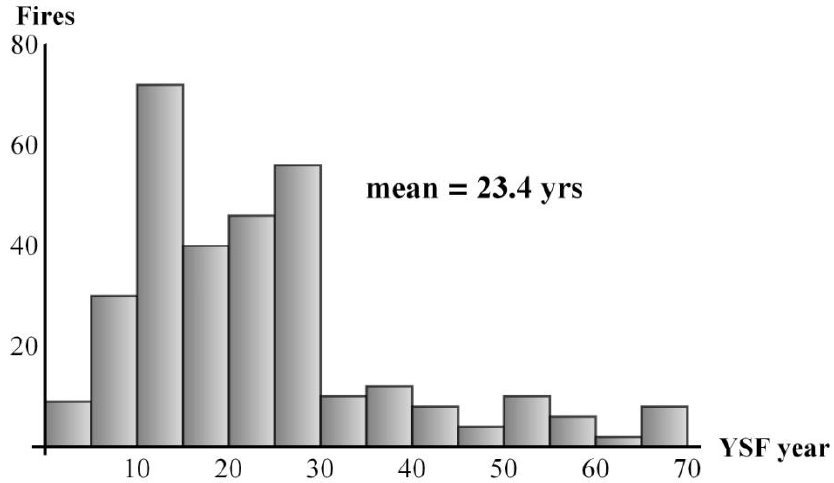
Figure 4. Number of intersected fire perimeters by years since fire